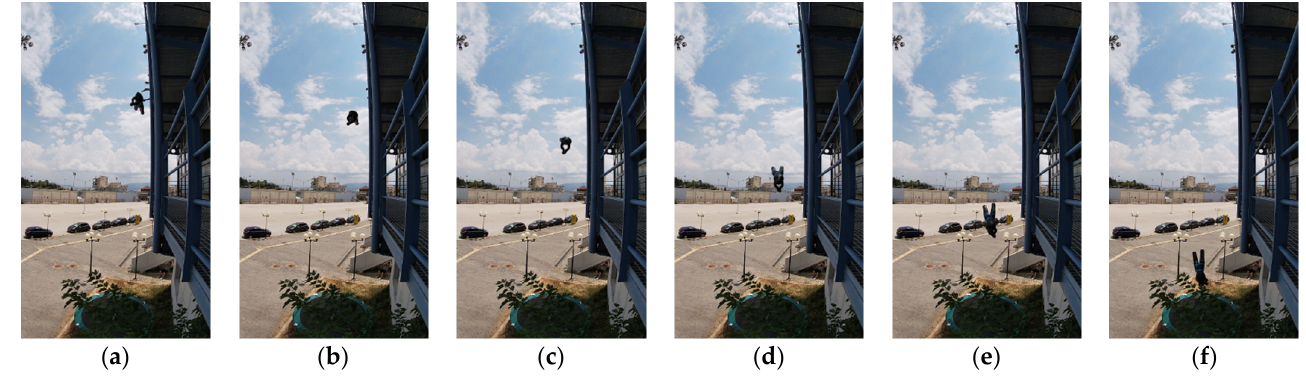
Figure 7. The freefall trajectory of the human dummy during a test throw. The deep networks were set to perform five detections per second, i.e., every 10th frame of the video sequence ( a – f